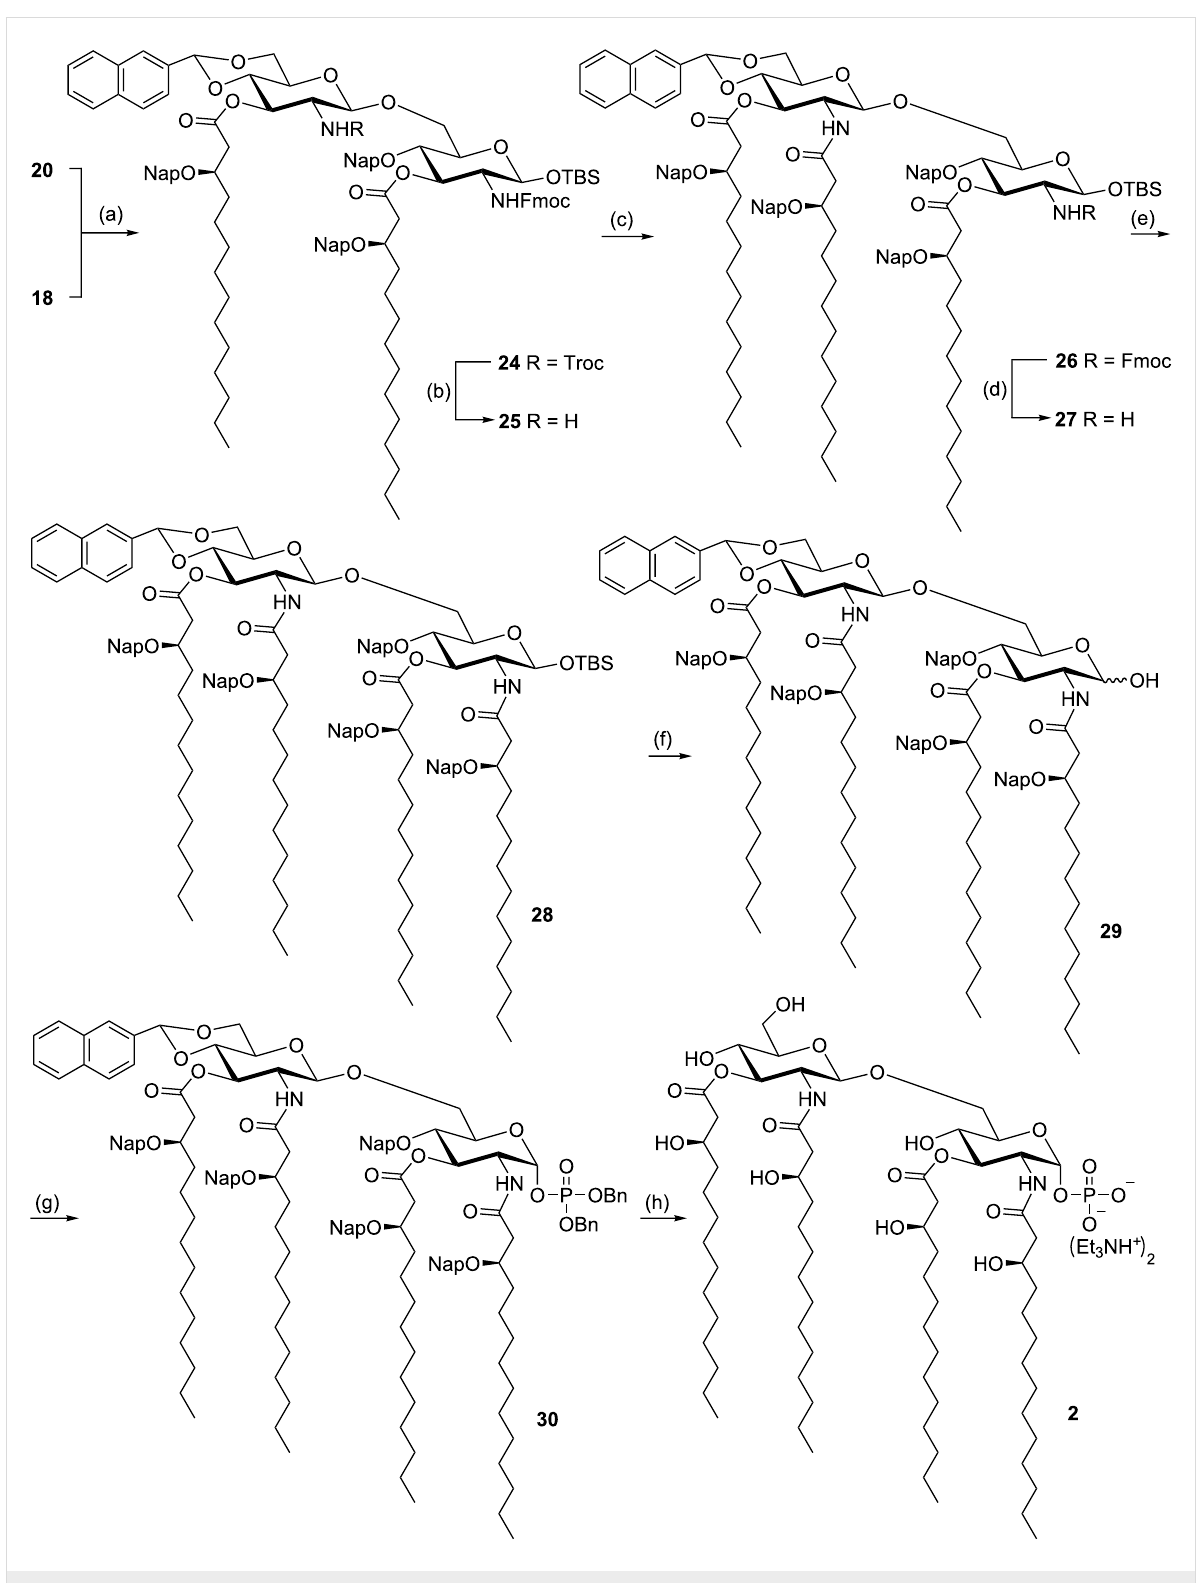
Scheme 4: Synthesis of the disaccharide lipid A precursor 2 . Conditions: (a) TfOH, 4 Å MS, dry CH 2 Cl 2 , 94%; (b) Zn, AcOH, CH 2 Cl 2 ; (c) acid 7 , EDC·HCl, DMAP, CH 2 Cl 2 , 88% (2 steps); (d) Et 3 N, DMF; (e) acid 7 , EDC·HCl, CH 2 Cl 2 , 82% (2 steps); (f) HF/pyridine, pyridine, THF, − 40 °C to rt, 92%; (g) tetrabenzyl pyrophosphate, LHMDS, dry THF, − 78 °C, 82%; (h) H 2 , Pd-black, THF, 38 °C,